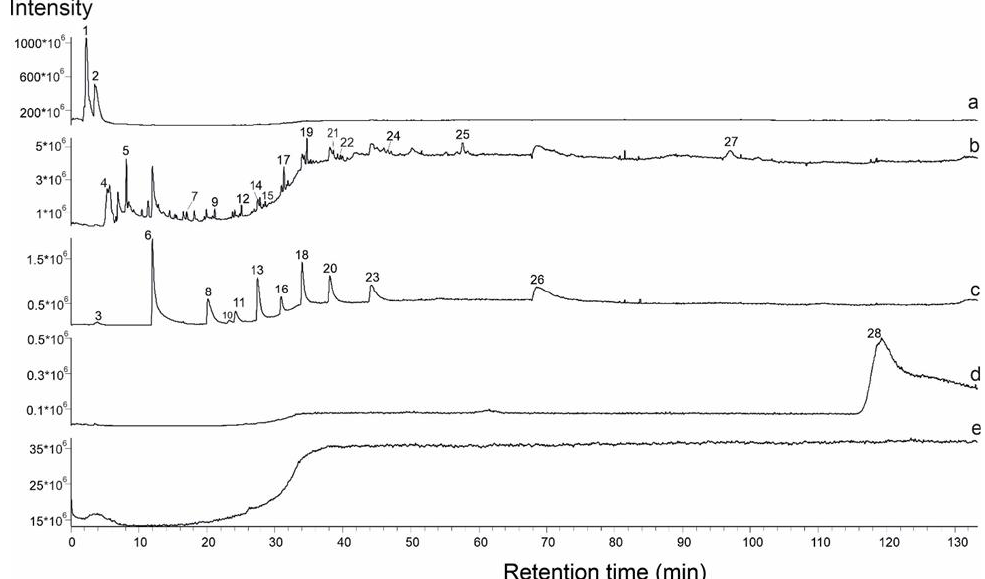
Figure 8. Results of a GC – MS analysis of volatiles extracted via mechanical shock crushing from quartz D10 of the Dobroe deposit. Total ion chromatogram (TIC) (a) and reconstructed ion chro- matograms (RIC) for m / z (43 + 57 + 71 + 85) (b), m / z 60 (c), m / z 149 (d), and blank (TIC) (e).